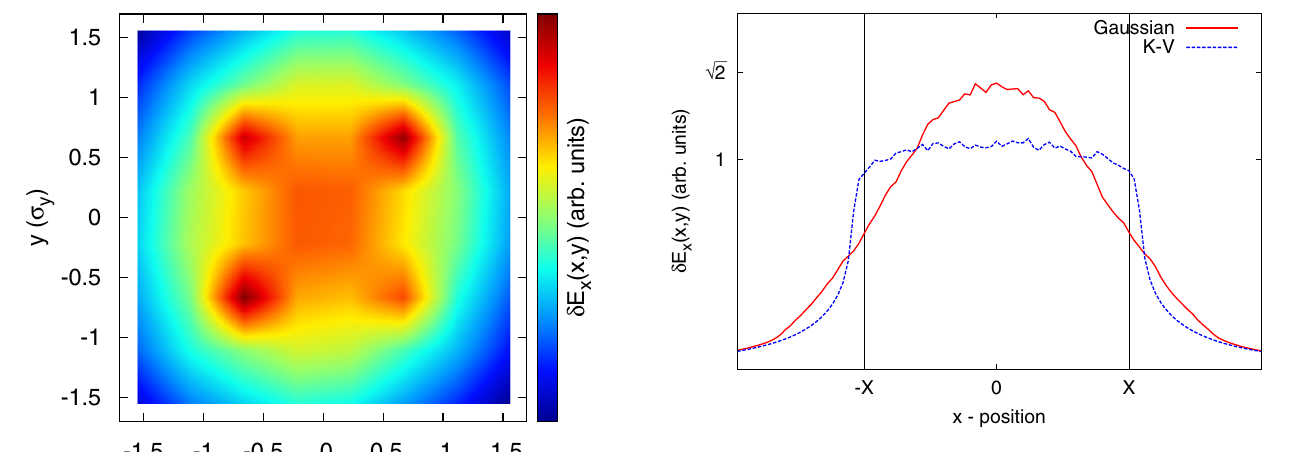
x; y Þ for a K-V distri- FIG. 2. Electric field fluctuations δ E x ð bution of size X ¼ 2 σ and a rms equivalent Gaussian beam. x Inside the beam, i.e., x ∈ ½ − X; X (cid:2) , the field fluctuations for the K-V distributions are approximately constant. FIG. 1. Standard deviation of the transverse electric field, see